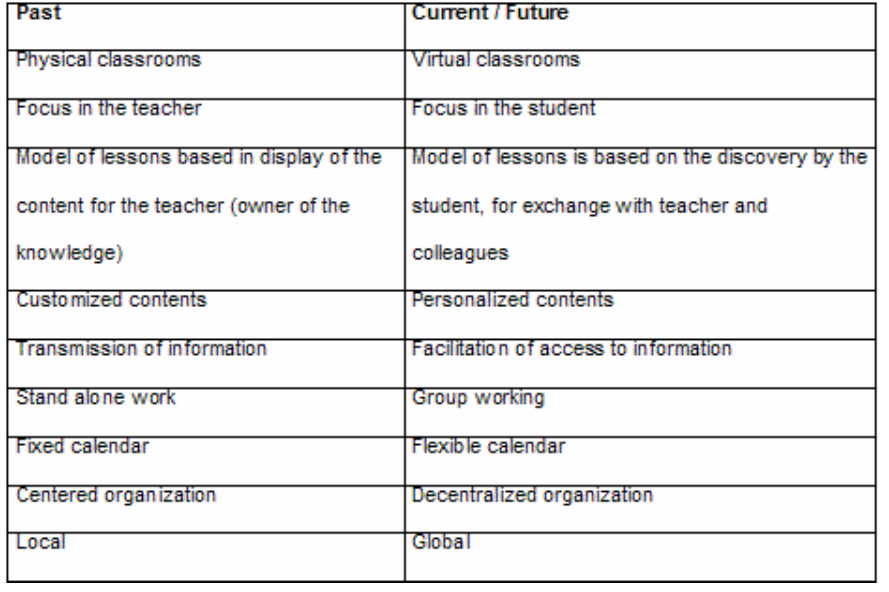
Table 1 . Past and Current/ Future of DE teaching and